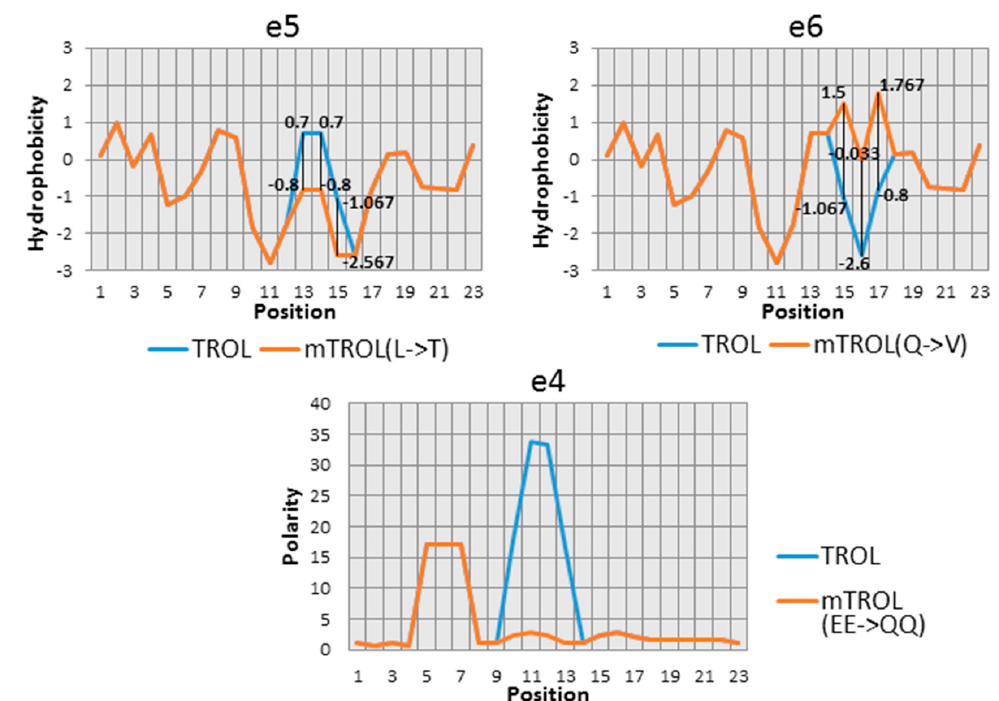
Figure 1. Kyte and Doolittle plots representing hydrophobicity change as a consequence of amino acid substitution/s in the TROL presequence [23]. Amino acids 67–78 of the partially conserved N-terminal part of the presequence around the predicted transit peptide cleavage site, AKSLTYEEALQQ, were substituted as follows: e1: 67Ala → 67Ile, e2: 71Thr → 71Asn, e3: 72Tyr → 72Val, e4:73Glu74Glu → 73Gln74Gln, e5: 76Leu → 76Thr, e6:78Gln → 78Val. For the e6 substitution, a polarity check according to Zimmerman was performed [24]. Table 1. Mutations introduced to the TROL presequence by the QuikChange Multi Site-Directed Mutagenesis and corresponding primer sequences.